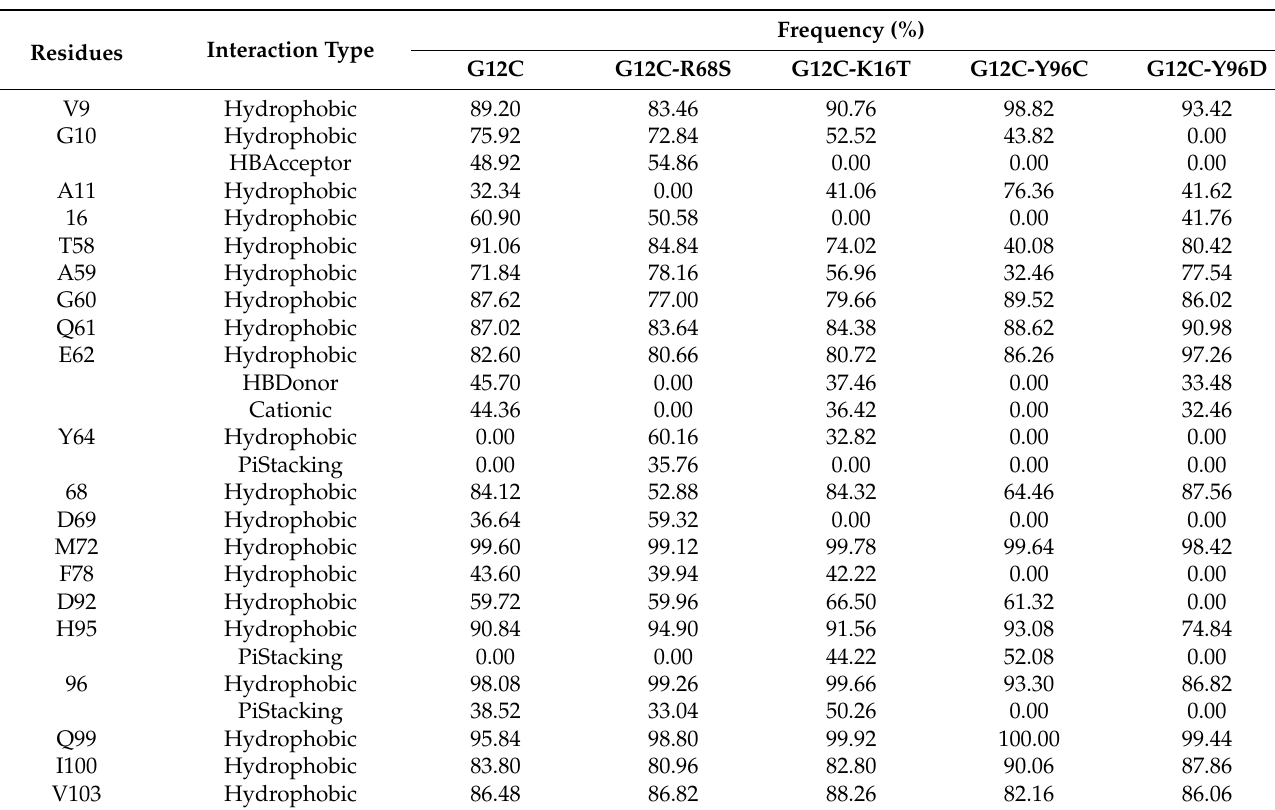
Table 4. Fingerprints of molecular interaction including the interaction types between MRTX849 and mutant KRAS